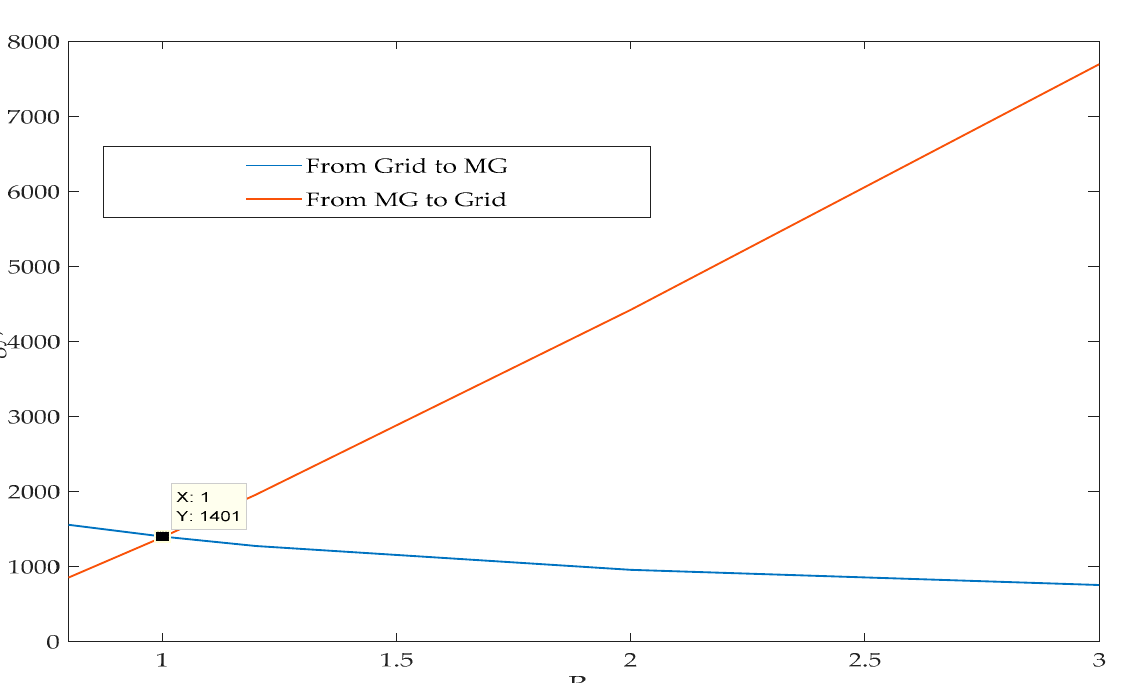
Figure 6. Energy from the utility grid (UG) to microgrid—MG. 0